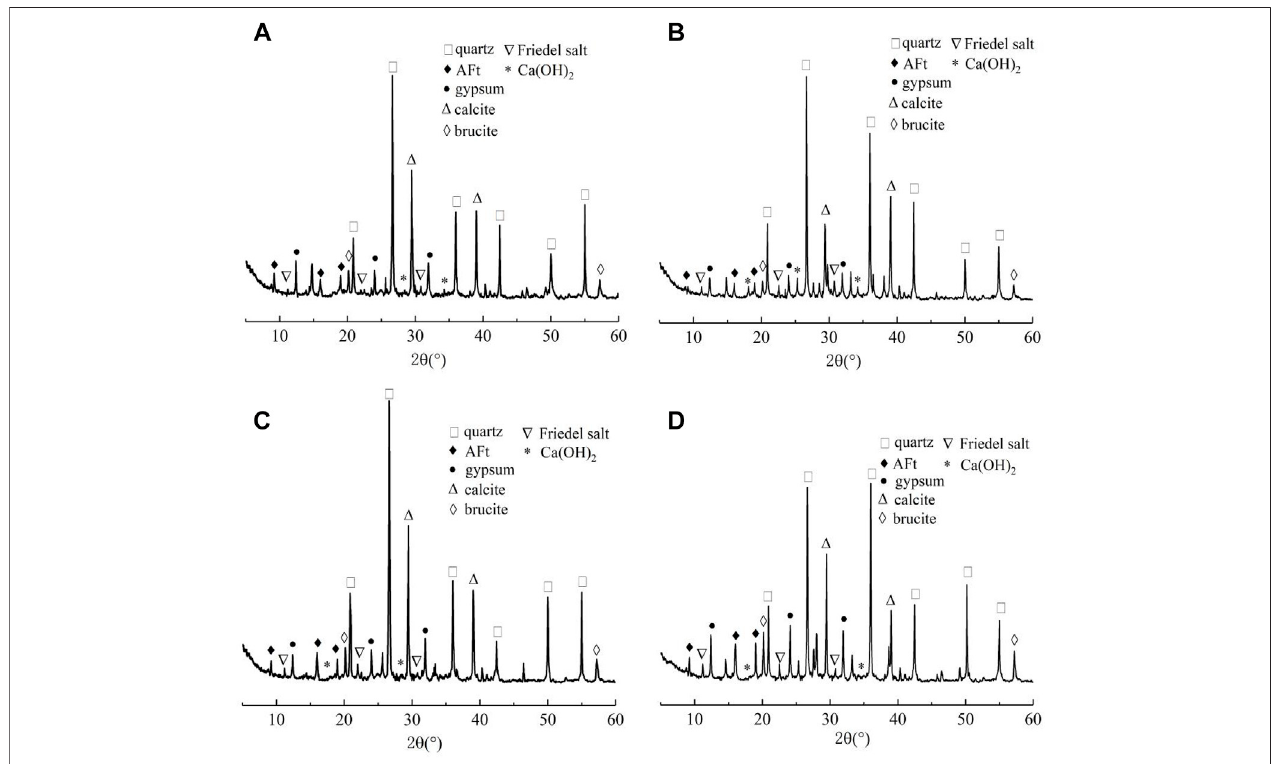
FIGURE 3 | XRD pattern of specimen when erosion days are 120 days: (A) MK0; (B) MK5; (C) MK10; (D) MK15.